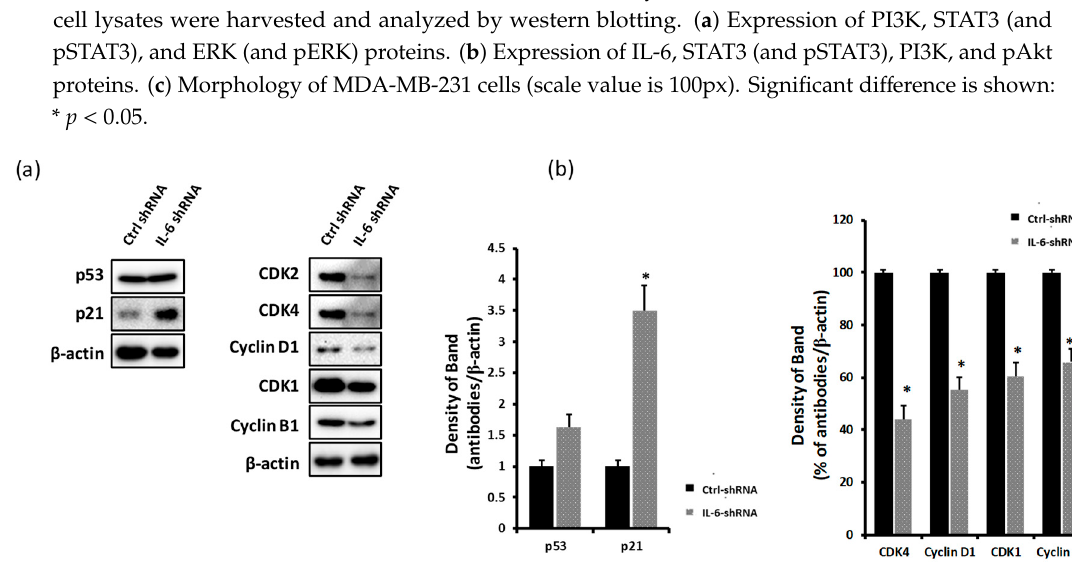
Figure 2. Blockade of IL-6 expression decreases the levels of pSTAT3, PI3K, and pAkt in MDA-MB- 231 cells. MDA-MB-231 cells were treated with anti-IL-6 antibody or IL-6 shRNA. After 24 h of incubation, cell lysates were harvested and analyzed by western blotting. ( a ) Expression of PI3K, STAT3 (and pSTAT3), and ERK (and pERK) proteins. ( b ) Expression of IL-6, STAT3 (and pSTAT3), PI3K, and pAkt proteins. ( c ) Morphology of MDA-MB-231 cells (scale value is 100px). Significant difference is shown: * p < 0.05.